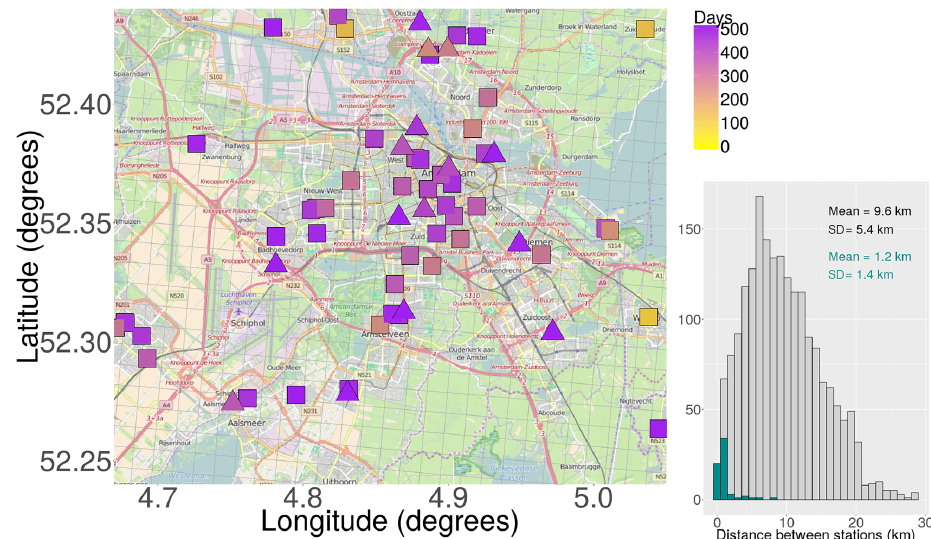
Figure 2. Locations and operational days (i.e., days with measurements) of Netatmo (squares) and other types (triangles) of PWSs, with the radar pixel grid in the Amsterdam metropolitan area. Inter-station distances are represented in the histogram, colored green for nearest neighbor distances. The background map is taken from © OpenStreetMap (www.openstreetmap.org).